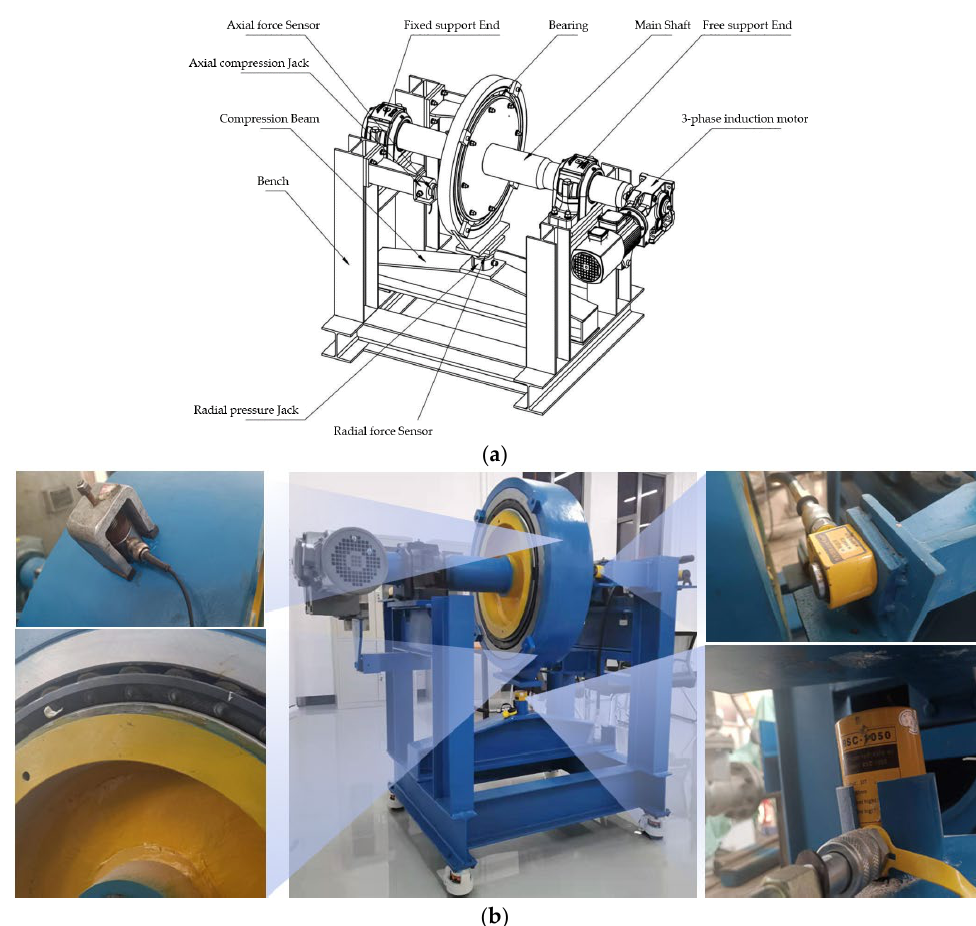
Figure 4. Bearing fault simulator: ( a ) diagram of the bearing fault simulator; ( b ) photographs of the bearing fault simulator. Table 2. Bearing parameters of indoor acoustic emission test bearing.